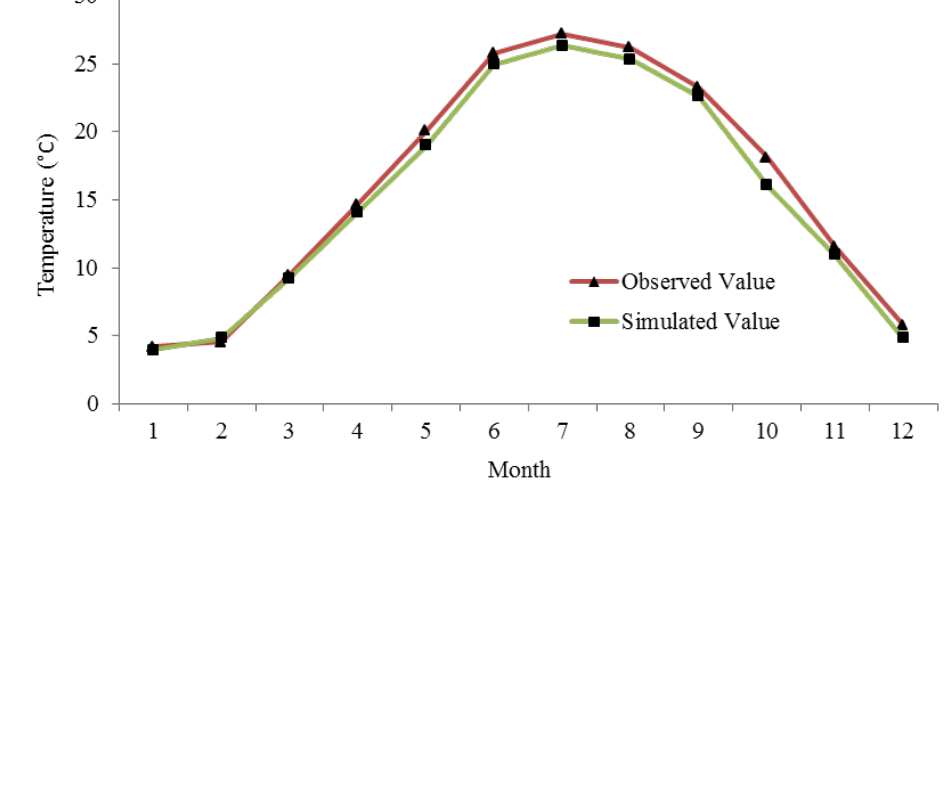
Figure A1. Simulated and observed values of the monthly average near-surface temperature of Northeast Megalopolis of the USA in